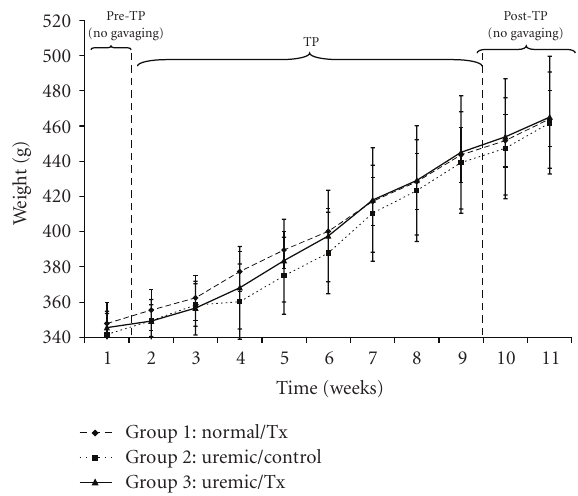
Figure 1: Rats’ body weight before, during and after oral adminis- tration of APA microencapsulated yeast cells.